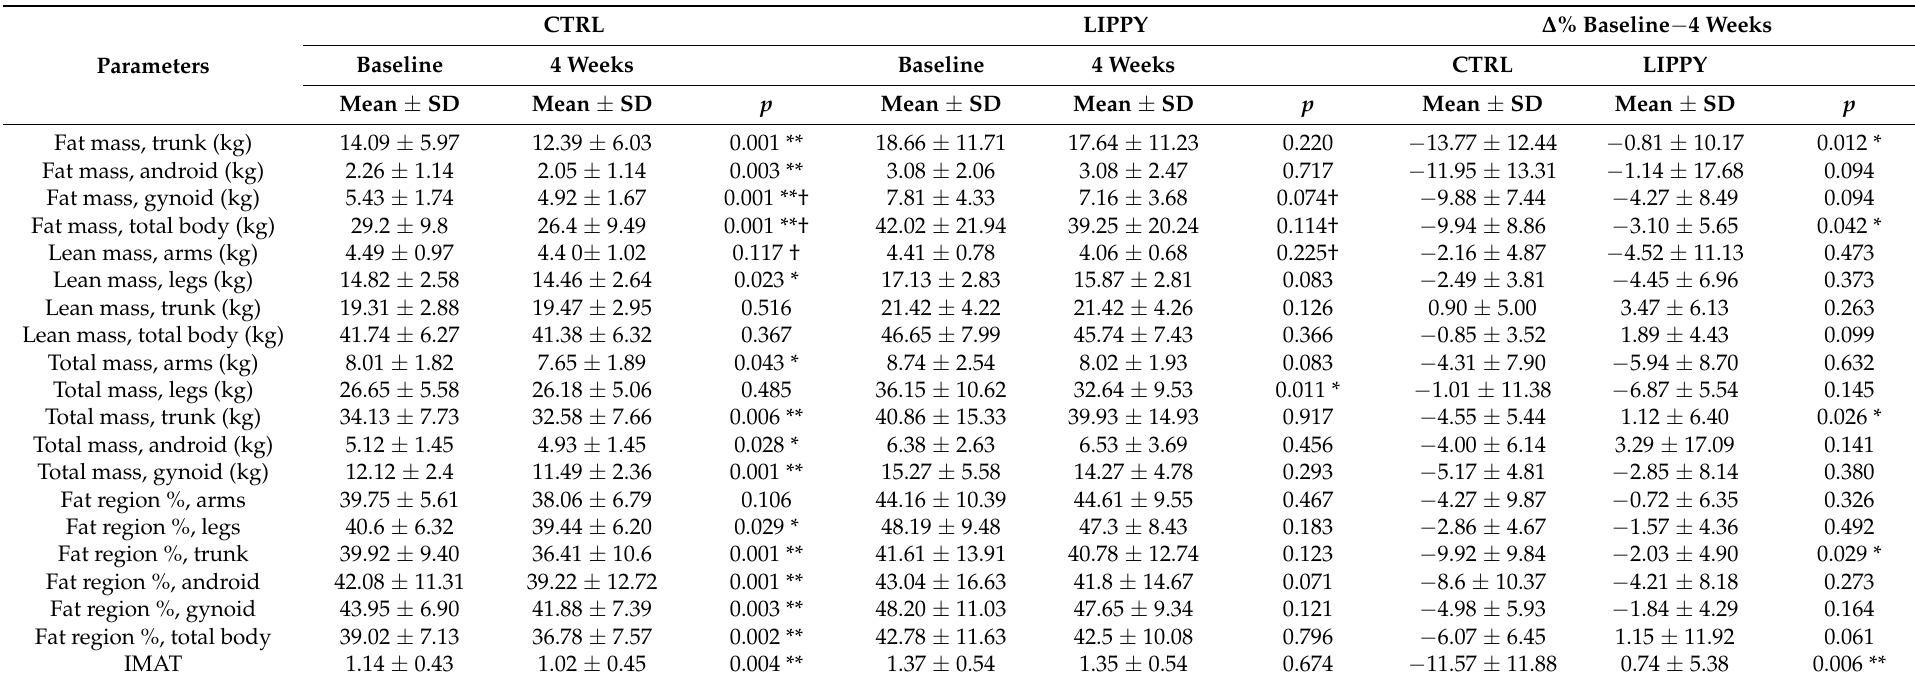
Table 3. Comparison of body composition variables between the baseline and after four